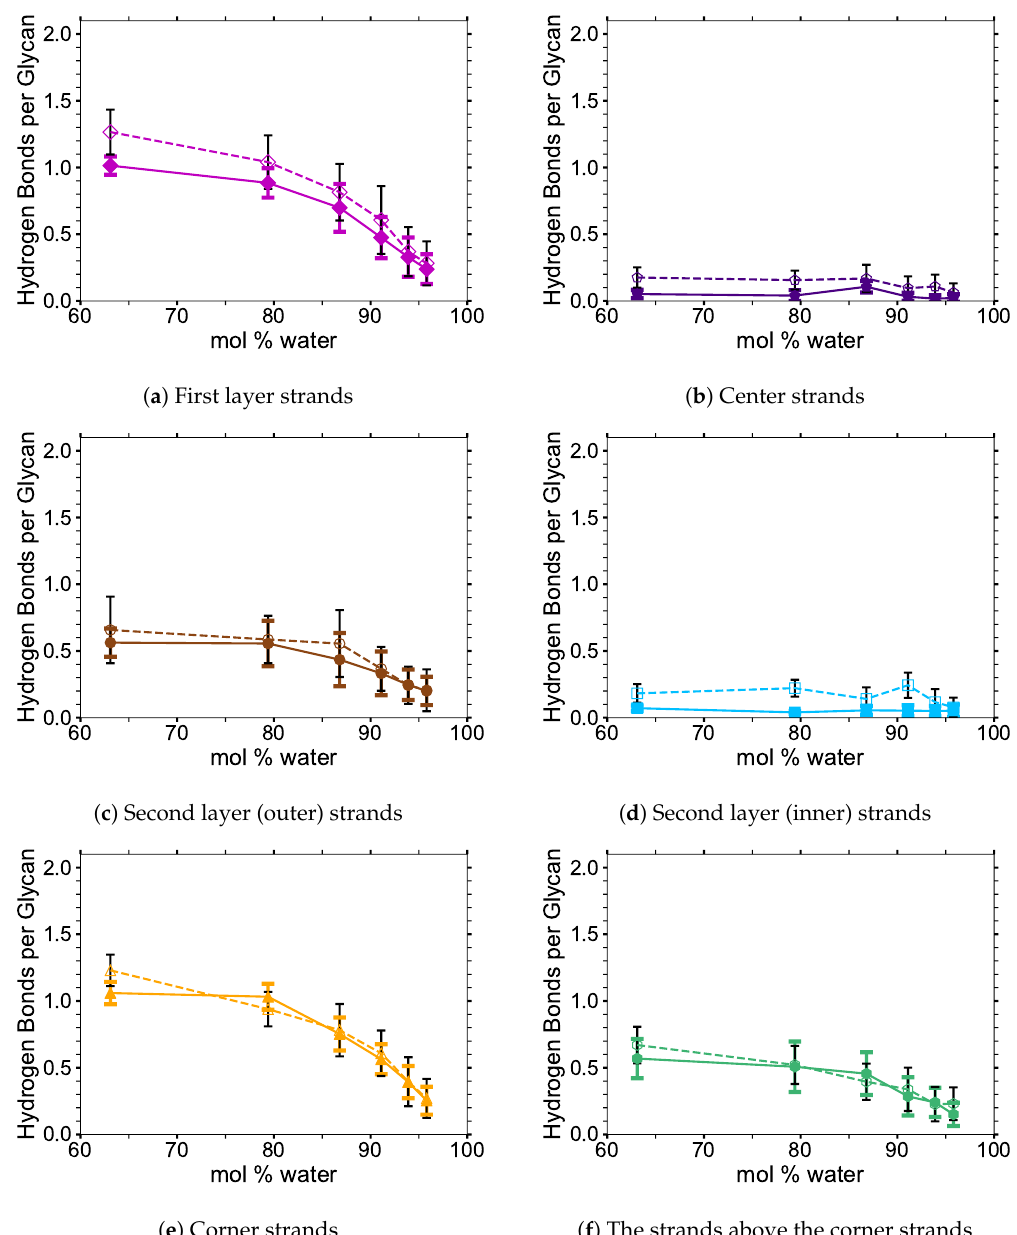
Figure A3. Average Cl-strand hydrogen bonding comparison with standard deviations between the small and large cellulose bundles at various water concentrations: ( a ) the first layer strands; ( b ) the center strands; ( c ) the second layer (outer) strands; ( d ) the second layer (inner) strands; ( e ) the corner strands; ( f ) the strands above the corner strands. All data points were averaged from 10 to 20ns. The solid lines, filled markers, and colored error bars represent the large cellulose bundle, and the dashed lines, unfilled marker, and black error bars show the small cellulose bundle. The colored strands are matched and compared between the plots for the small and large bundles and the images to identify similar hydrogen bonding behavior based on their locations (see Figure 6a,b for the color-coded images). The black cellulose strands are not